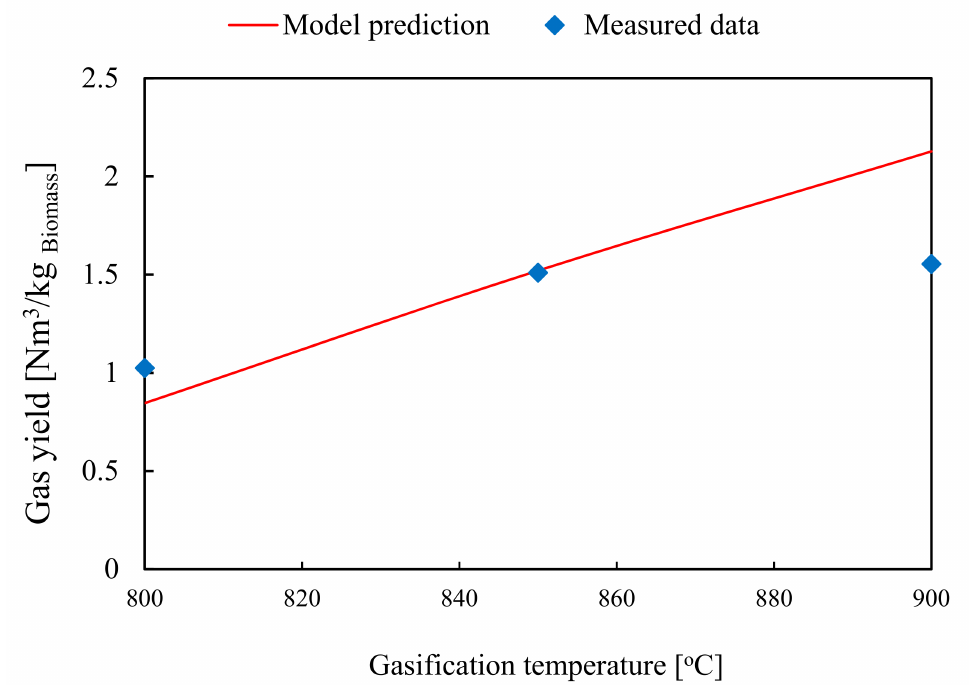
Figure 5. Effect of gasification temperature on the gas